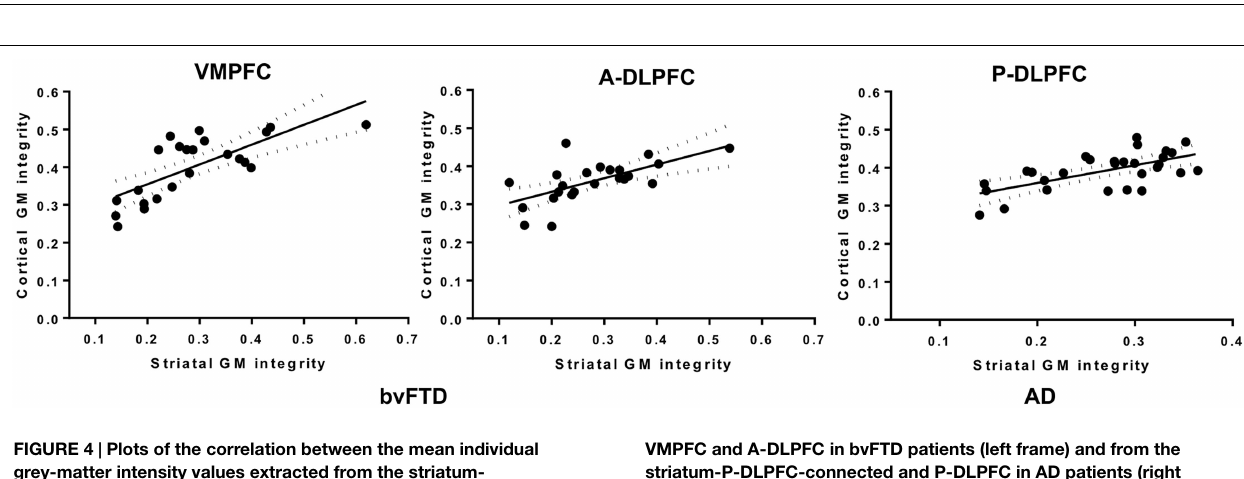
FIGURE 3 | Voxel-based morphometry analyses showing areas that were atrophic in bvFTD compared to AD . Results were only found in VMPFC and A-DLPFC ROIs. Clusters are overlaid on the MNI standard brain. Colored voxels show regions that were significant in the analyses for